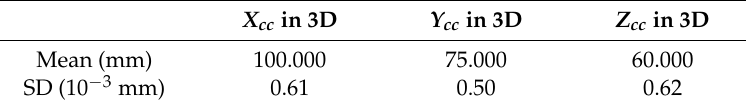
Figure 11. Simulated plane and cone scanned by the CC. Table 3. Center of intersection points and